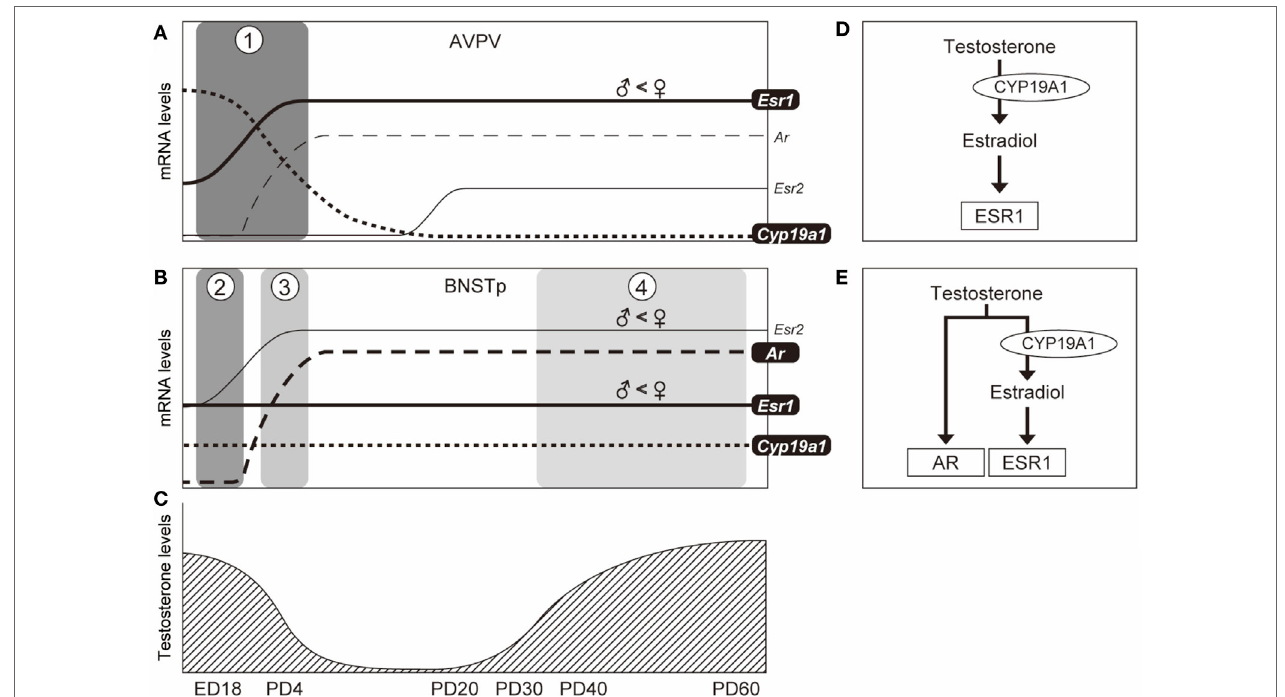
FigUre 6 | Schematic illustration of the temporal expression patterns of genes in the AVPV and BNSTp and possible testicular testosterone actions on the formation of the AVPV and BNSTp in male mice. In the AVPV [ panel (a) ], based upon our previous (23) and current studies, Esr1 mRNA expression ( solid line ) increases from embryonic day 18 (ED18) to PD4 and continues in the pubertal period. Cyp19a1 mRNA level ( dotted line ) decreases from ED18 to PD4 and is not expressed by PD20. Esr1 and Cyp19a1 are essential to the formation of the male AVPV, but Esr2 and Ar are not necessary (23). Testicular testosterone production reaches a peak level at ED18 and decreases after birth (50), and again is increased from PD35 (44) [ panel (c) ]. The temporal patterns of Esr1 , Cyp19a1 , and testicular testosterone may indicate that the male AVPV is organized by estradiol (formed by the aromatization of testosterone) signaling through ESR1 during the perinatal period [ boxed phase 1 in panel (a) and panel (D) ]. In the BNSTp [ panel (B) ], based upon our previous (23) and current studies, Esr1 mRNA ( solid line ) is expressed during the perinatal period, and is also expressed during the pubertal period. Cyp19a1 mRNA level ( dotted line ) is stably expressed in the perinatal and pubertal periods. Ar mRNA ( broken line ) is not expressed in the late fetal period (ED18), but expressed in the postnatal (PD4) and pubertal periods. Esr1 , Cyp19a1 , and AR are requisite for the sexual differentiation of the male BNSTp (23, 26). The patterns of Esr1 , Cyp19a1 , Ar , and testicular testosterone levels may indicate that the male BNSTp is formed by the action of estradiol (formed by the aromatization of testicular testosterone) via ESR1 in the fetal period [ boxed phase 2 in panel (B) and panel (D) ], and both the action of estradiol via ESR1 and testicular testosterone via AR in the postnatal [ boxed phase 3 in panel (B) and panel (e) ] and pubertal [ boxed phase 4 in panel (B) and panel (e) ]